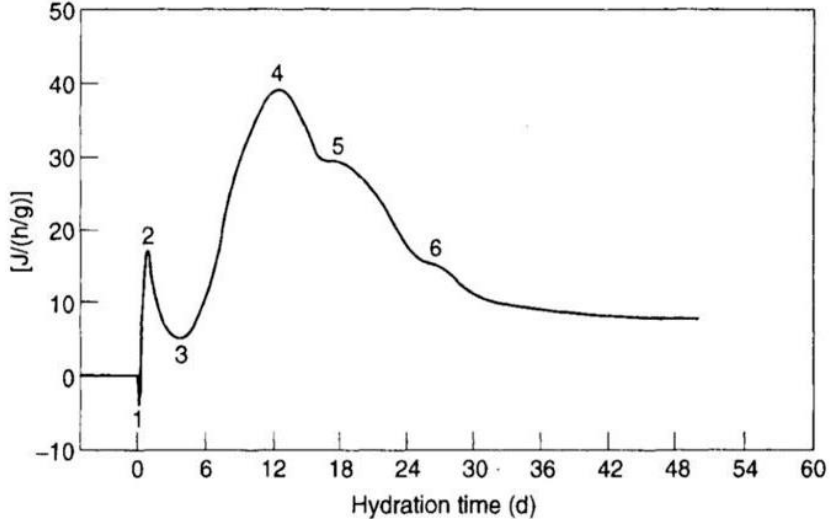
Figure 5. Hydration heat evolution of an OPC vs. hydration time. Step 1: K 2 SO 4 dissolution. Step 2: Early-stage period. Step 3: Dormant period. Step 4: Middle-stage period (C-S-H formation). Step 5: AFt formation. Step 6: Aft–AFm conversion. Reprinted with permission from [1].